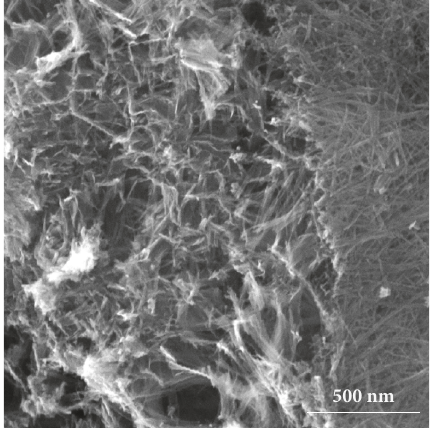
Figure 1: FESEM image of TNTs prepared via 72-h hydrothermal synthesis at 130 ∘ C and after heating at 400 ∘ C for 5 h.